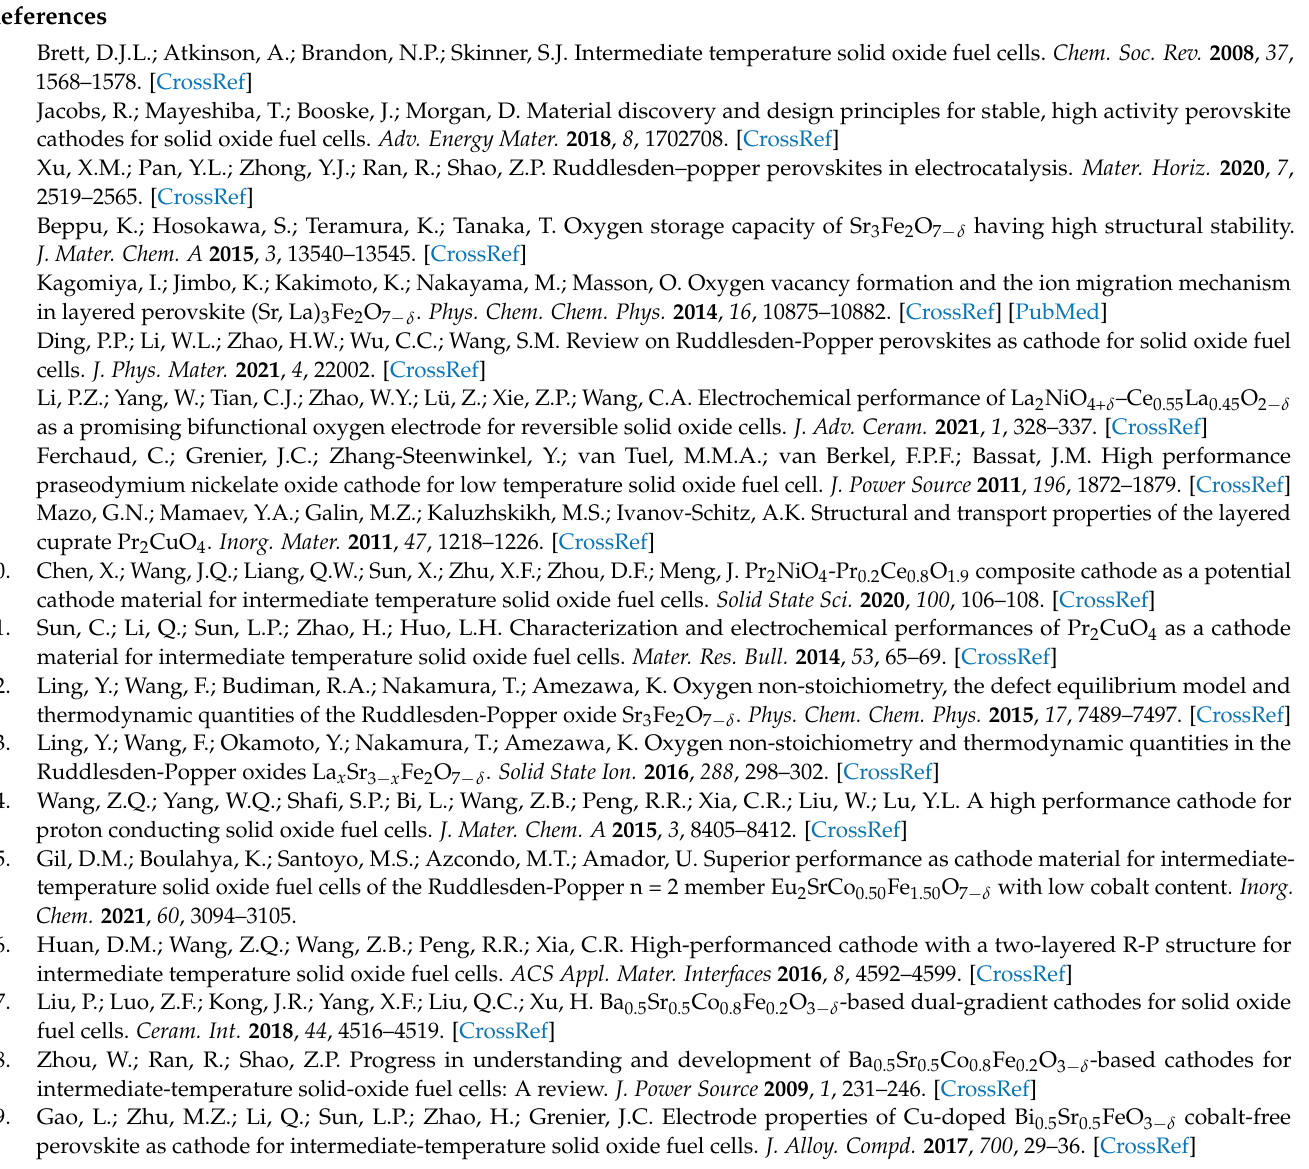
pressures, Figure S2: The schematic of the anode-supported single cell, Figure S3: I - V and I - P curves of the single cells with SFC10 cathode at 600–700 ◦ C, Table S1: Lattice parameters of the SFC x